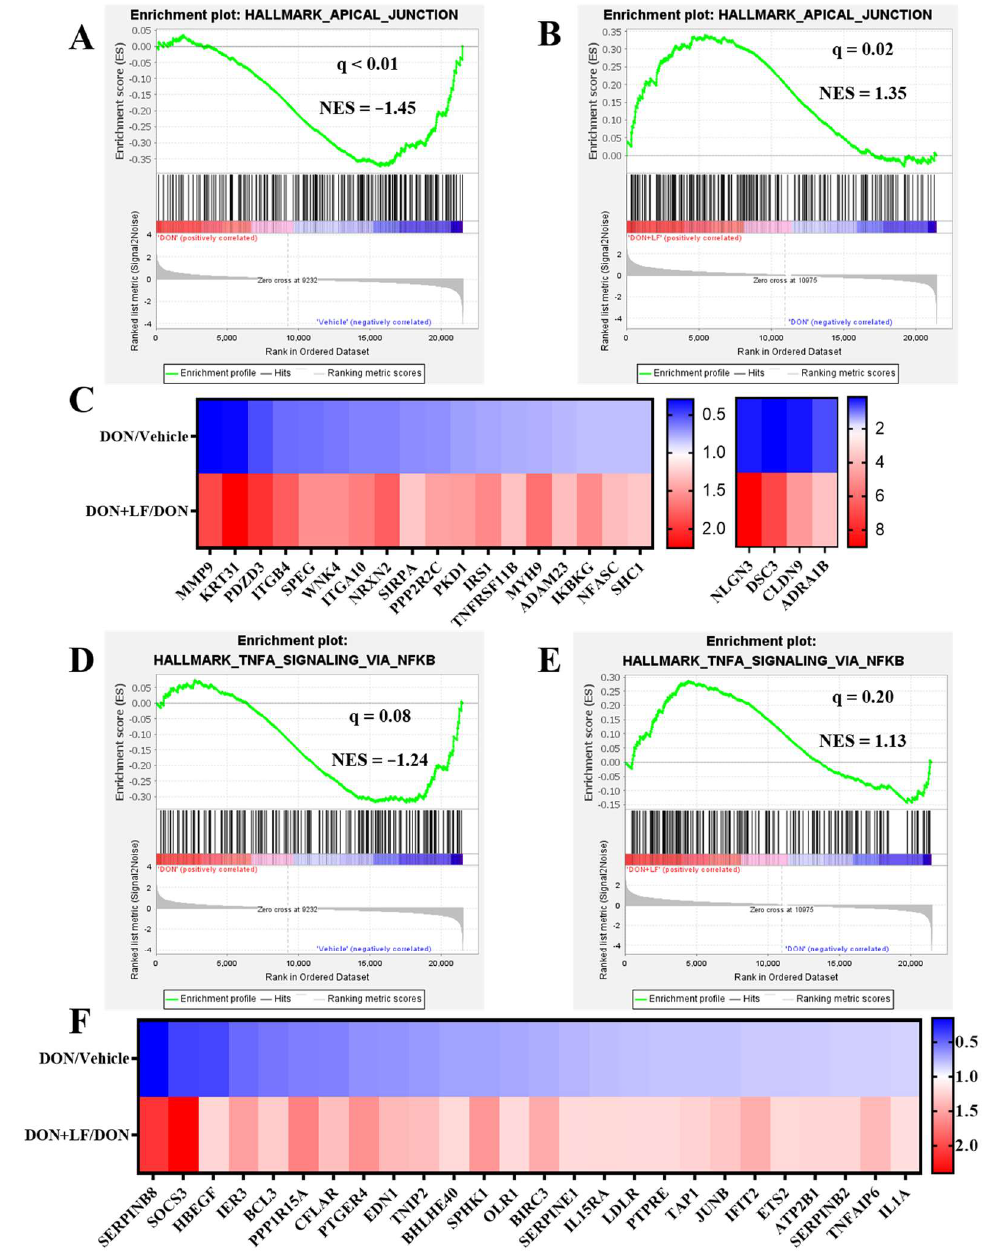
Figure 6. The GSEA plots indicated down-regulated gene expressions involved in apical junction and TNFα signaling via NFκB of testes in the DON group compared to the vehicle and normalizing effects of LF in the DON + LF group compared to the DON group. ( A , B ) GSEA plots depicting the enrichment of genes involved in apical junction that were down-regulated in the testes of DON- treated mice compared to the vehicle and up-regulated in the testes of DON-LF co-treated mice compared to those in the DON group. ( C , F ) Heatmap of mRNA expression (RNA-seq) changes of the apical junction and TNFα signaling via NFκB genes in the testes of DON and LF treated mice (log2 transformed, normalized to vehicle for DON group, and normalized to DON group for DON + LF group). ( D , E ) GSEA plots depicting the enrichment of genes involved in TNFα signaling via NFκB genes that were down-regulated in the testes of DON-treated mice compared to the vehicle and up-regulated in the testes of DON-LF co-treated mice compared to those in the DON group.